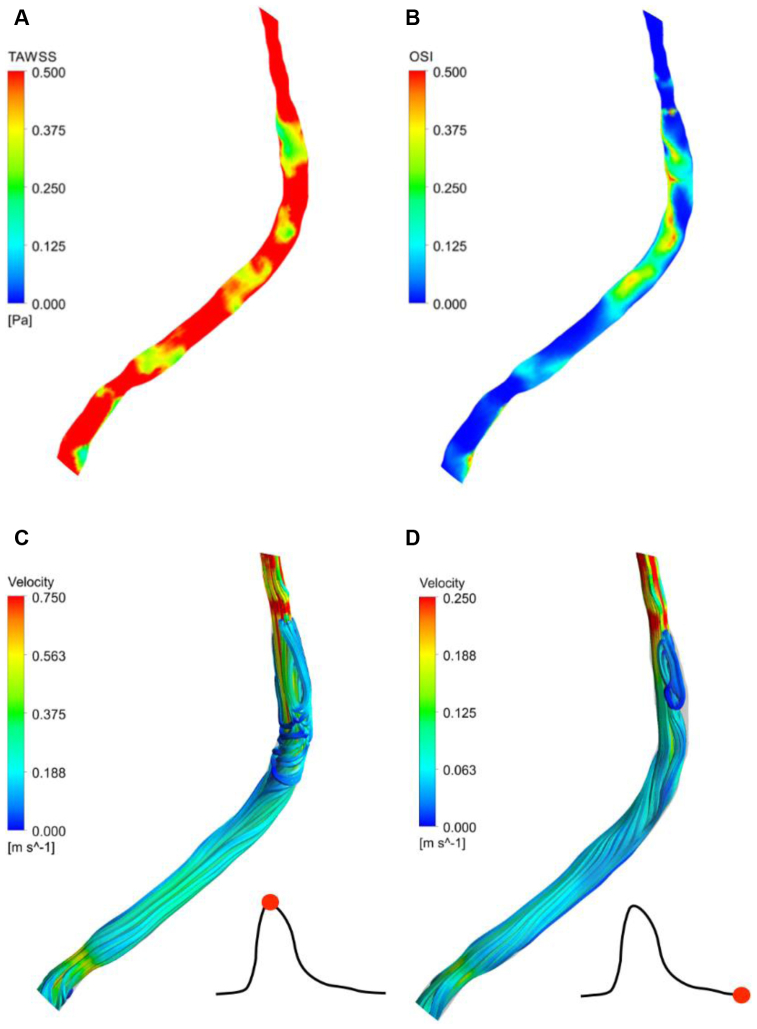
Contour plots of time-averaged wall shear stress (TAWSS) and oscillatory shear index (OSI) and velocity streamlines at peak systole and end diastole in patient 2. A, TAWSS. B, OSI. C, Velocity streamlines at peak systole. D, Velocity streamlines at end diastole.